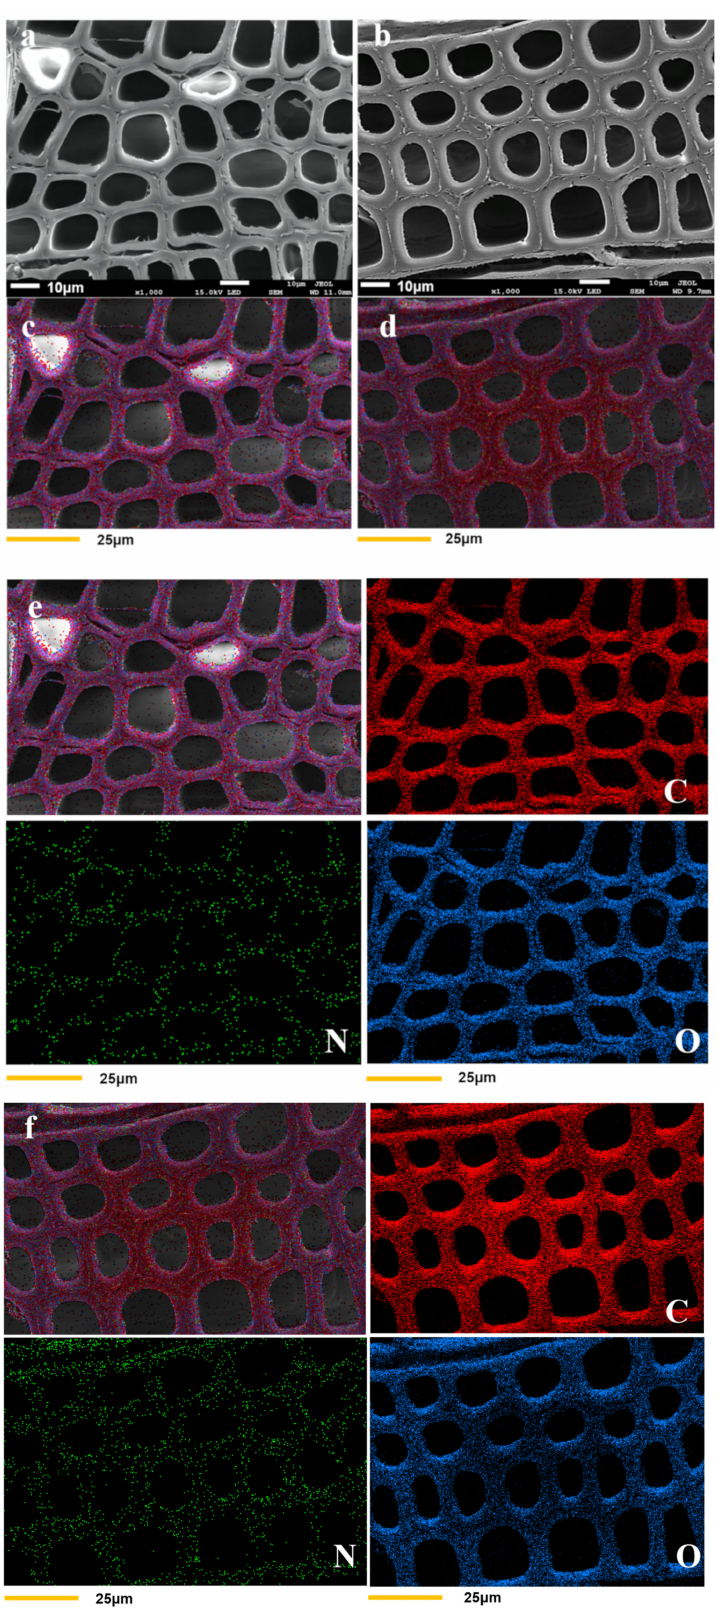
Figure 2. SEM morphologies of unmodified ( a ) and modified ( b ) wood samples, ( c , d ) are energy spectrum figures of untreated and treated wood, respectively. Samples ( e , f ) show the distribution of C, N, and O elements in the cell walls of unmodified and modified